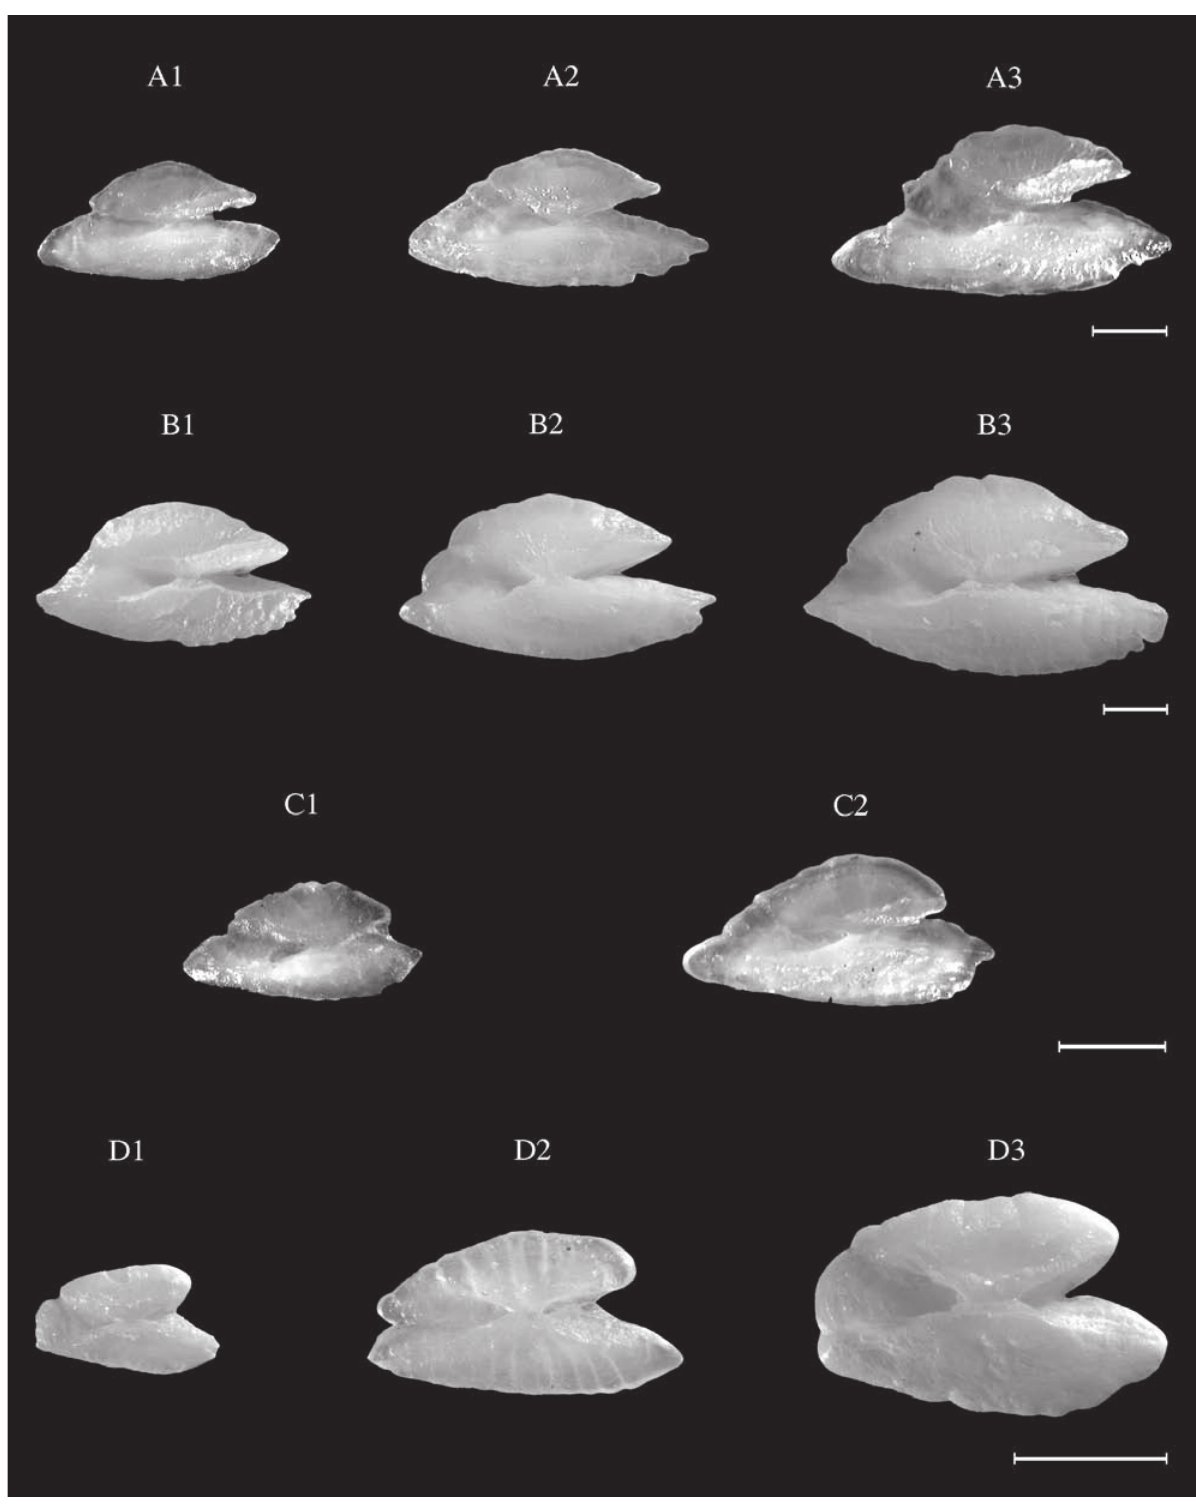
Fig. 69. – Labrus merula (WM). TL: A1, 19.0 cm; A2, 28.5 cm; A3, 33.0 cm. Labrus mixtus (NEA). TL: B1, 20.3 cm; B2, 24.1 cm; B3, 29.7 cm. Labrus viridis (WM). TL: C1, 11.5 cm; C2, 18.5 cm. Symphodus bailloni (NEA). TL: D1, 6.0 cm; D2, 11.3 cm; D3, 16.5 cm. Scale bar = 1